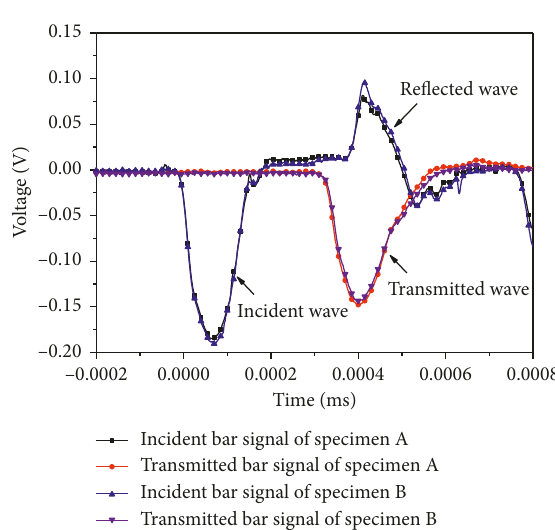
Figure 4: Typical waveform of a compression